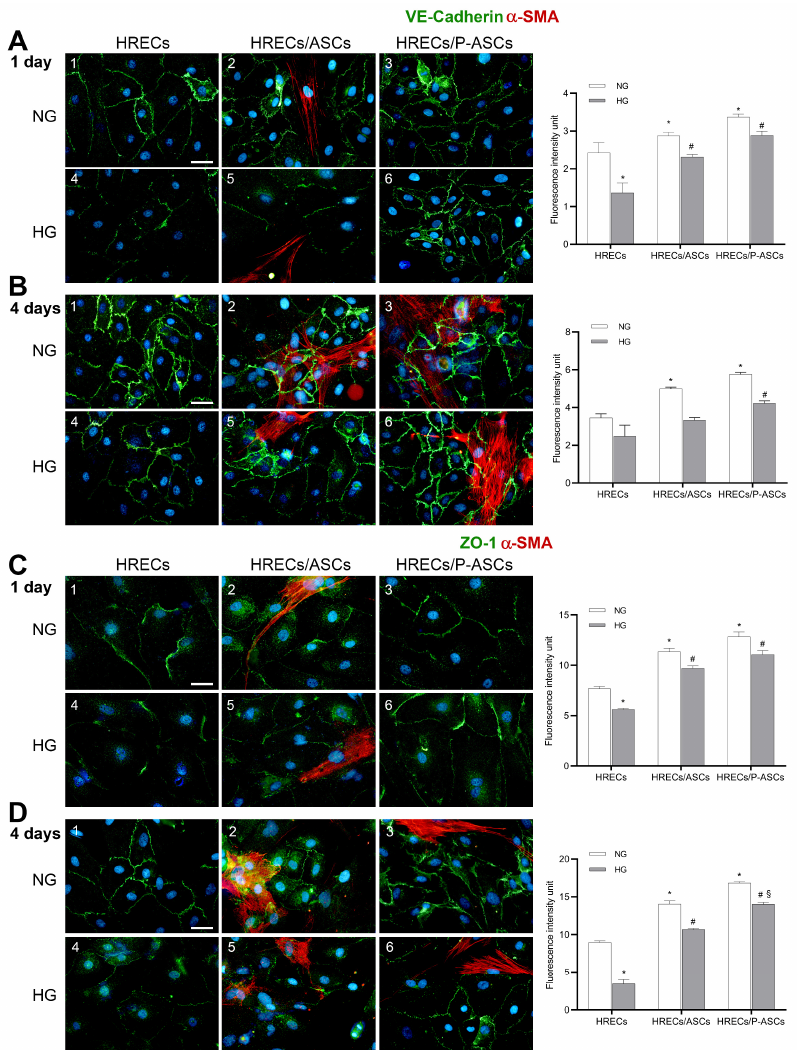
Figure 2. Double-labeling immunofluorescence experiments in co-cultures of human retinal endothelial cells (HRECs) and human adipose-derived mesenchymal stem cells (ASCs) or pericyte-like ASCs (P-ASCs). Micrographs obtained after 1 day ( A – C ) and 4 days ( B – D ) of mono- or co-culture, in NG or in HG. Photos A1, B1, C1, and D1 refer to HREC monocultures, taken as a reference: only VE-cadherin ( A , B ) or ZO-1 ( B – D ) immunostainings are present. In both control NG-HRECs, at day 4 (B-1 and D-1), the immunofluorescence signals were higher than at day 1 (A-1 and C-1), revealing the greater time-dependent expressions of both junction proteins and confirming the characteristic intercellular contacts, typical of blood–retinal barrier cells. In NG, the fluorescent signals were significantly stronger when HRECs were in direct mixed cultures with ASCs (A2, B2, C2, and D2) and, even more, with P-ASCs (A3, B3, C3, and D3) for both proteins at the two time points. The fluorescence related to both VE-cadherin and ZO-1 reduced significantly in HG incubation (A4, B4, C4, and D4). However, strong recoveries were observed in HRECs conditioned by ASCs (VE-cadherin, A5 and B5; ZO-1, C5 and D5) and, more significantly, by P-ASCs (VE-cadherin, A6 and B6; ZO-1, C6 and D6). No α -SMA immunoreactivity is noticeable in A1-2, B1-2, C1-2, and D1-2, which refer to HRECs in monoculture. DAPI staining of cell nuclei is indicated by blue fluorescence. Overall, these results indicate that, even in HG concentrations, the presence of P-ASCs is able to preserve the integrity of junction proteins. Scale bar: 50 µ m. Histograms on the right side of each panel refer to quantification of fluorescence intensity. Values are expressed as the mean ± SEM of results from three independent experiments, with four parallel samples per group in each experiment. * p < 0.05 vs. HRECs in NG; # p < 0.05 vs. HRECs in HG; § p < 0.05 HRECs/P-ASCs in HG vs. HRECs/ASCs in